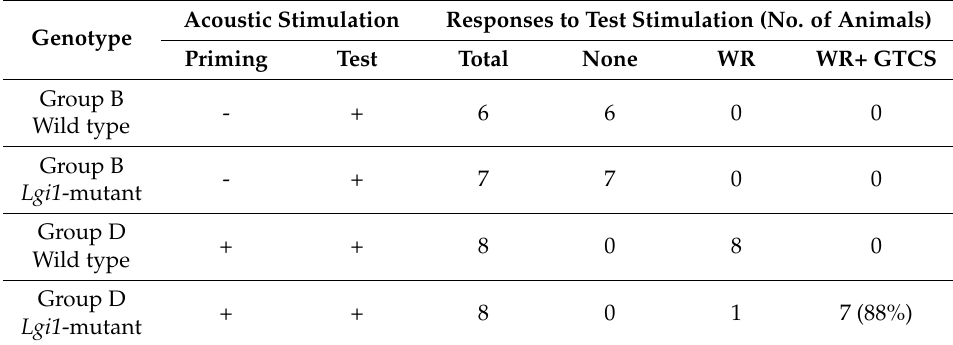
Figure 1. Audiogenic seizure induction. Wild-type rats and leucine-rich glioma-inactivated 1 ( Lgi1 ) mutant rats were divided into four groups: Group A (no acoustic stimulation), Group B (only test stimulation), Group C (only priming stimulation), and Group D (both priming and test stimulation). Table 1. The responses to acoustic test stimulation at eight weeks in wild-type rats and Lgi1 mutant rats. WR: wild running; GTCS: generalized tonic–clonic seizure.